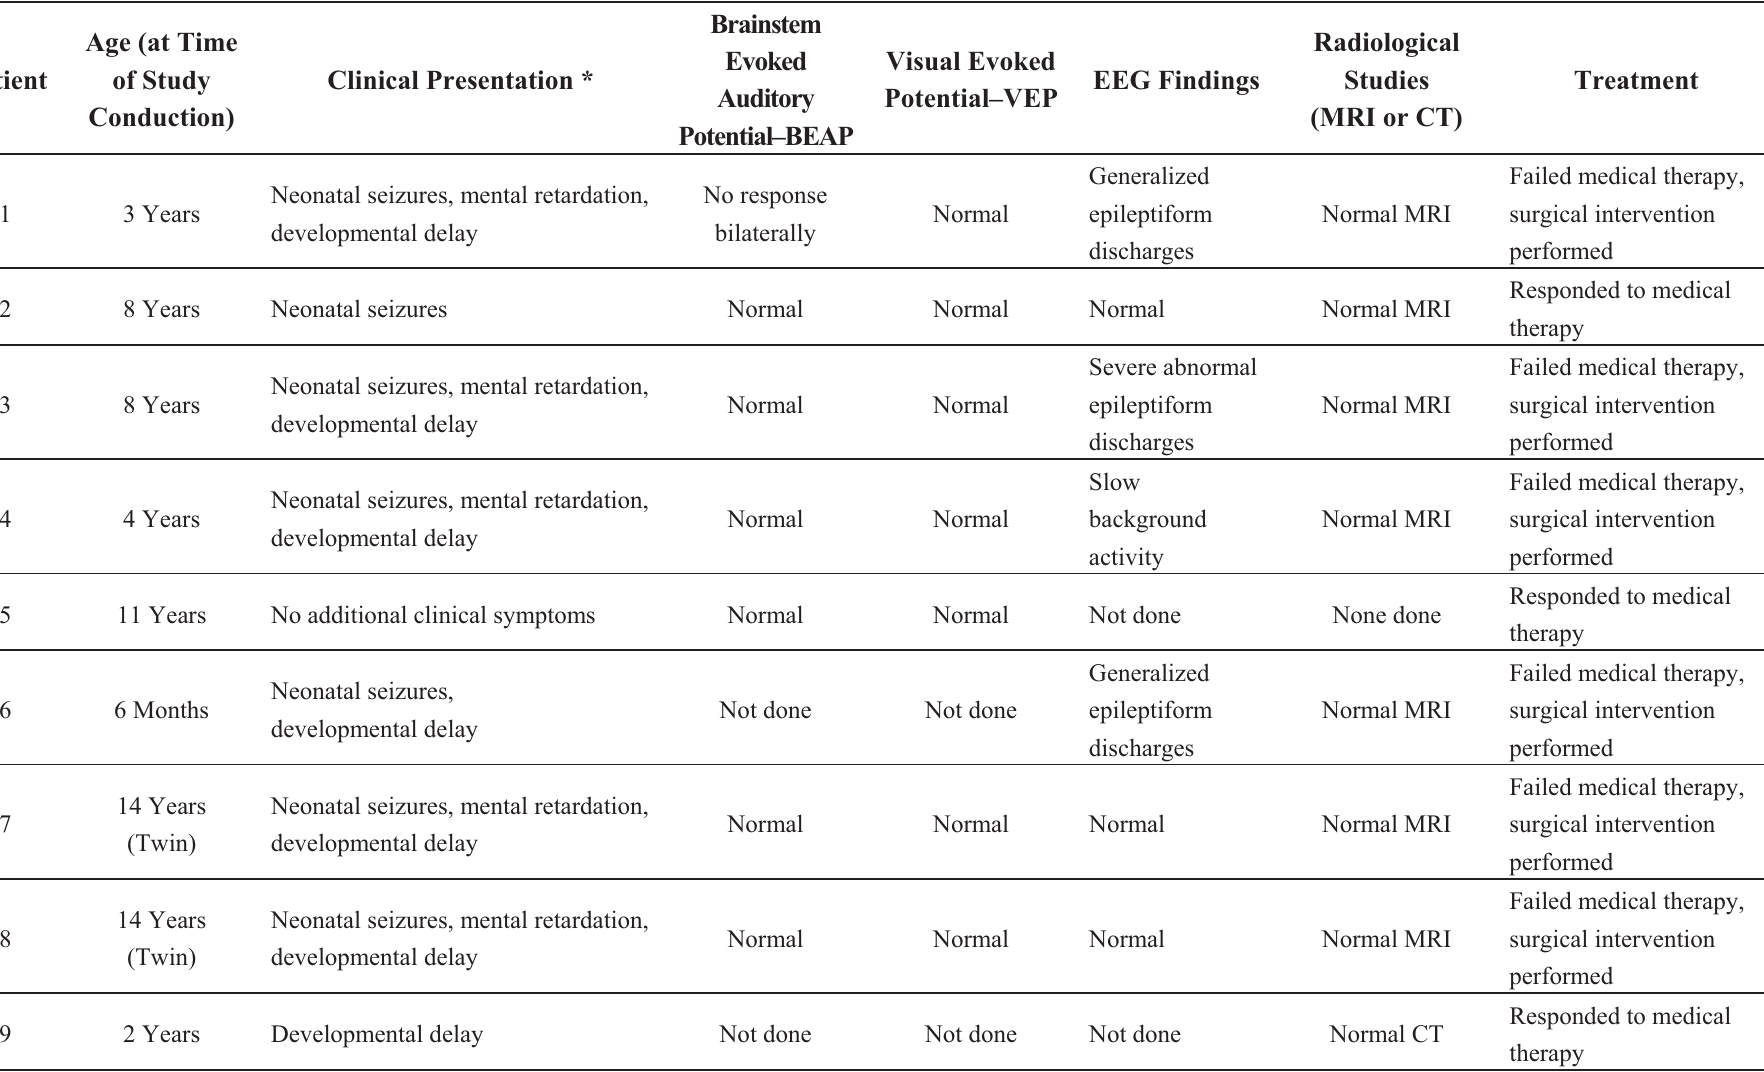
Table 1. Summary of clinical data for the patients in this